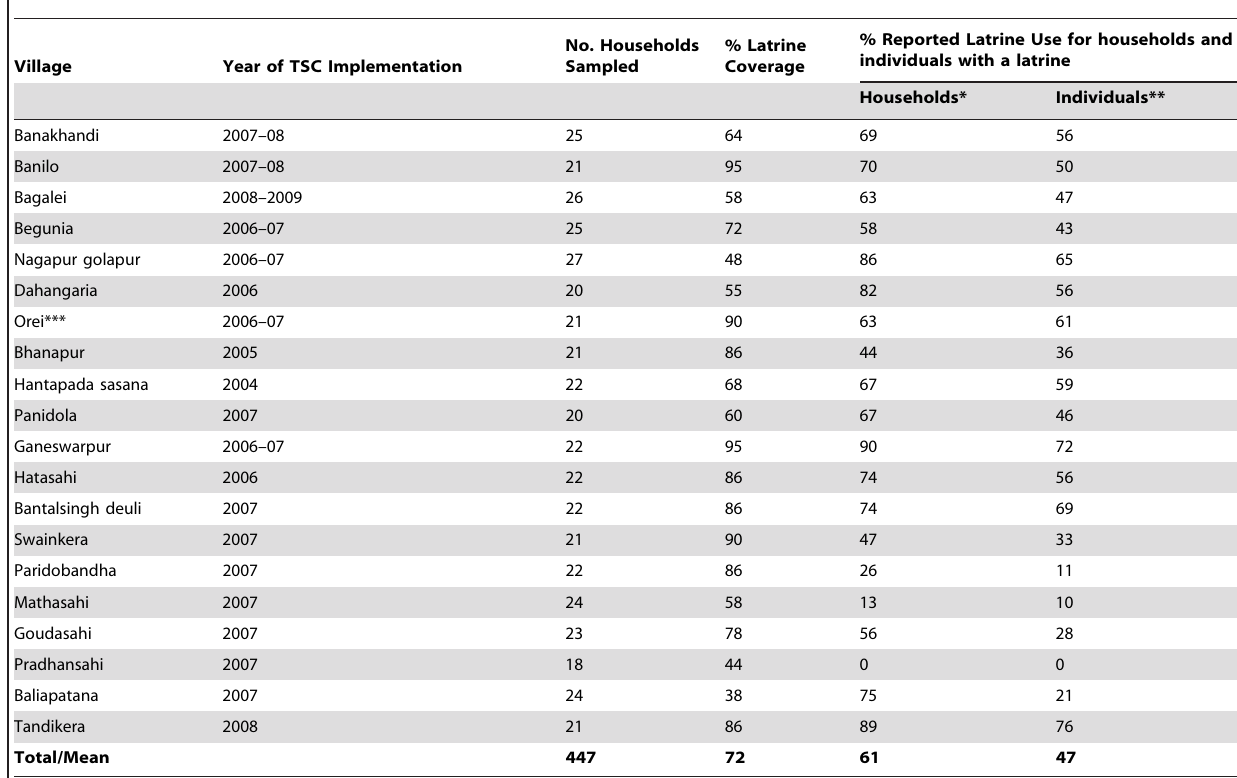
Table 1. Village, year of implementation, implementing partner, coverage and use.